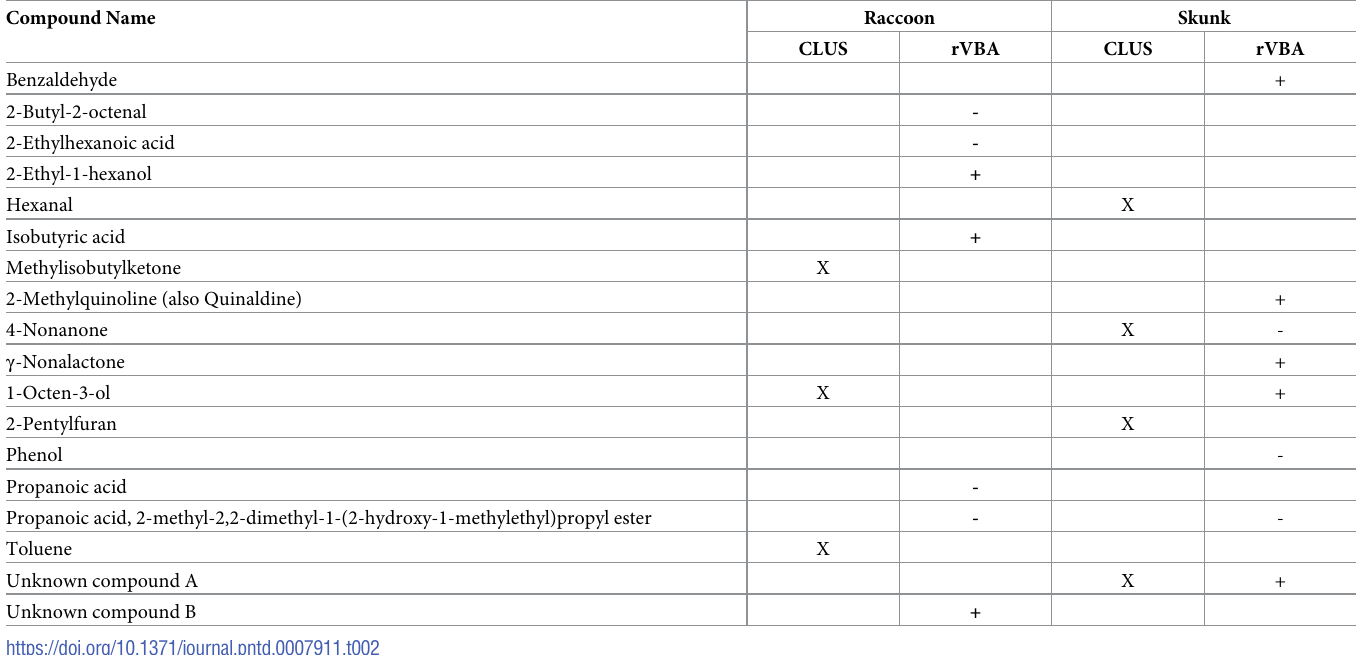
Table 2. Tentative compound identifications for chromatographic peaks belonging to volatile clusters associated vaccination (CLUS) or immune regression model (rVBA) where symbol identifies positive regression coefficients (+) or negative regression coefficients